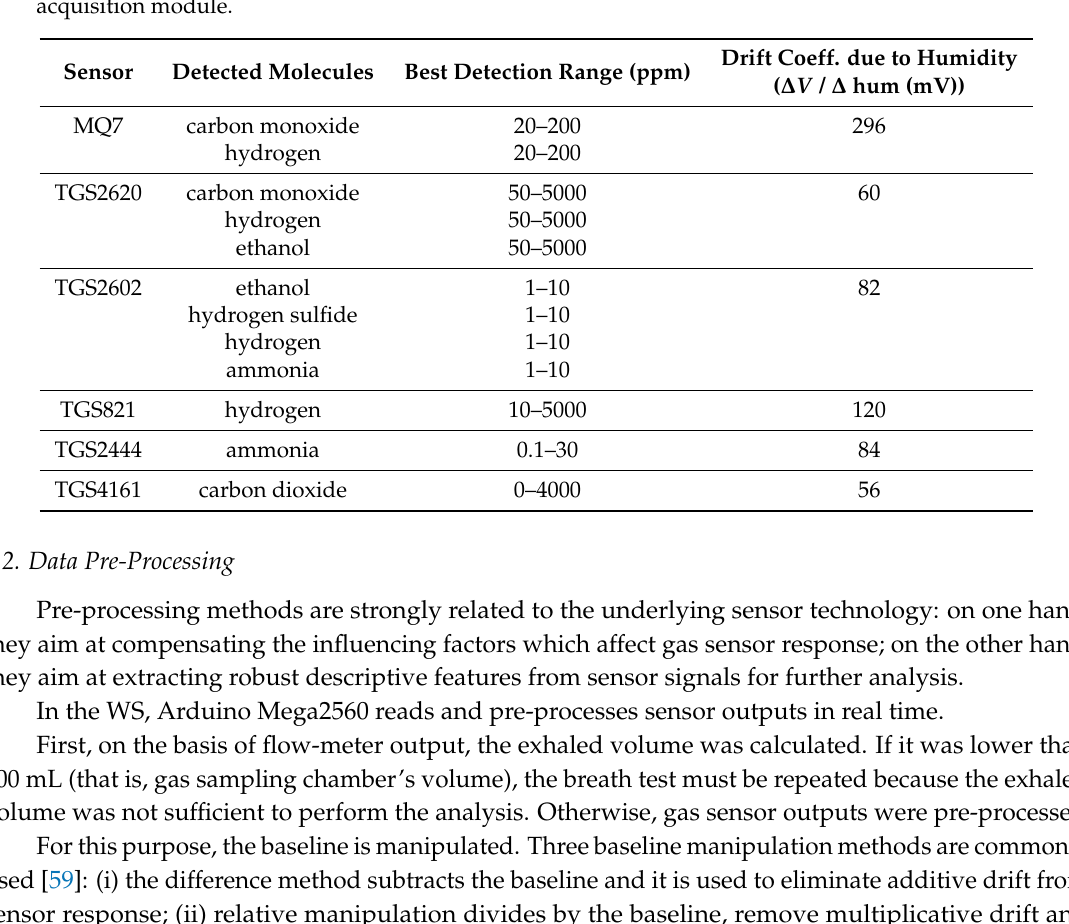
Table 1. Metal oxide semiconductor (MOS)-based gas sensors embedded into Wize Sniffer (WS) acquisition